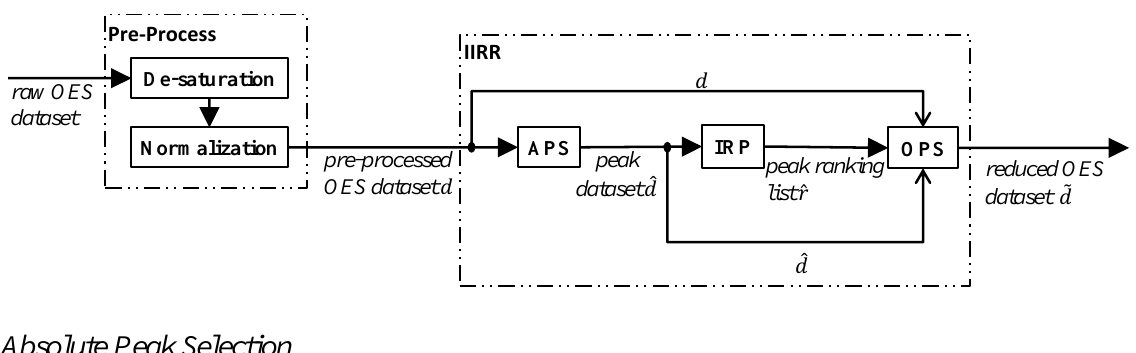
Figure 1. Workflow of